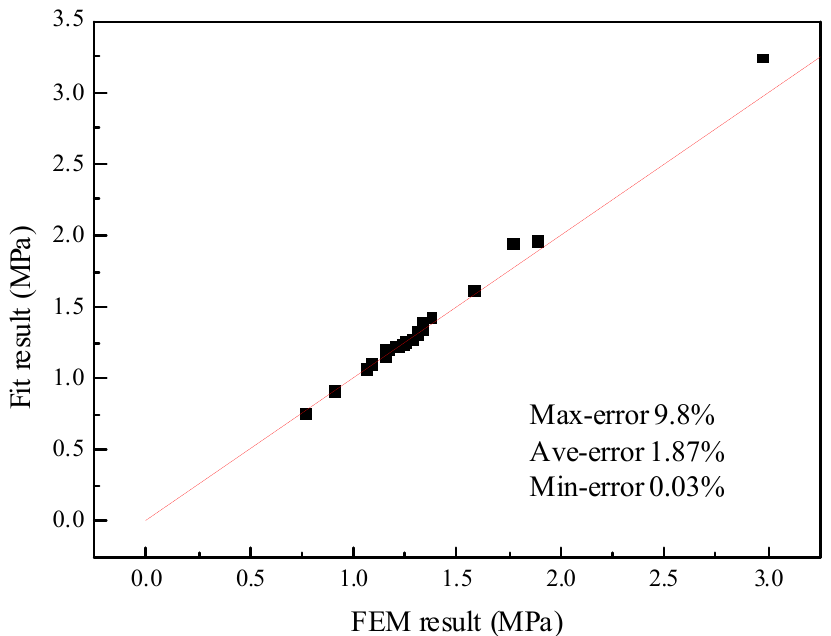
Figure 22. Correlation results between the prediction formula and the finite element model.